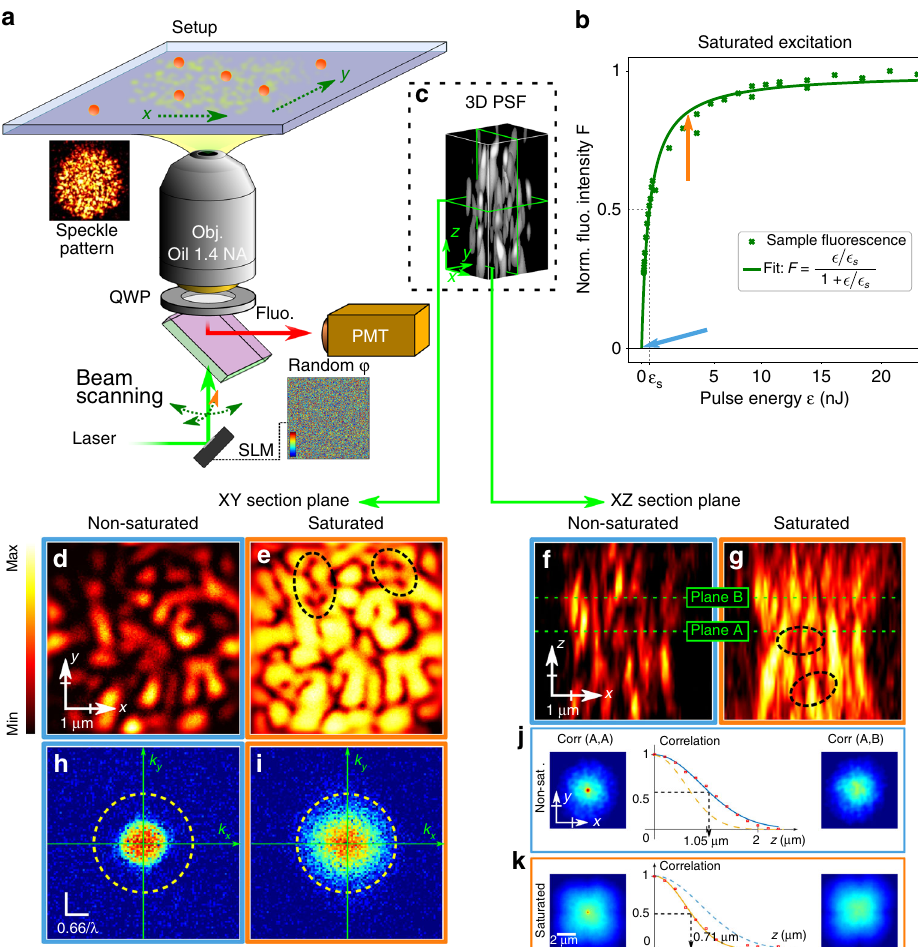
Fig. 1 Principle of our speckle scanning microscope. A circularly polarized random wave- fi eld generated by a spatial light modulator (SLM) — displaying a random phase mask — and a quarter wave-plate (QWP) is focused and scanned through an objective lens onto a fl uorescent sample ( a ). The fl uorescence signal from a thin and dense layer of fl uorescent beads illuminated with a speckle is plotted in ( b ), as a function of the exciting-pulse energy. The curve is fi tted with Eq. (1). The 3D speckle point spread function (SPSF) can be experimentally characterized by scanning a single fl uorescent nano-bead in three dimensions ( c ). The speckle in the transverse plane ( d , e ) and in a longitudinal plane ( f , g ) are shown for low pulse-energy ( 〈 s 〉 = 5 × 10 − 3 in ( d , f ) and for high pulse-energy ( 〈 s 〉 = 3.7) in ( e , g ). Black dotted ellipses in ( e ) and ( g ) point out dark points identifying the plane crossing by optical vortex lines. The power spectra of SPSFs in ( d , e ) are represented in ( h , i ), respectively, illustrating the transverse power spectrum enlargement due to saturated excitation (dotted circles in ( h , i ) materialize the spectrum boundary in ( i ), as a visual reference). Cross-correlation products between different transverse planes A and B is shown in ( j , k ), in the nonsaturated and in the saturated case, respectively. In both regimes, the plots show that the cross-correlation peak vanishes with increasing defocus under saturated excitation conditions. Saturation decreases the correlation